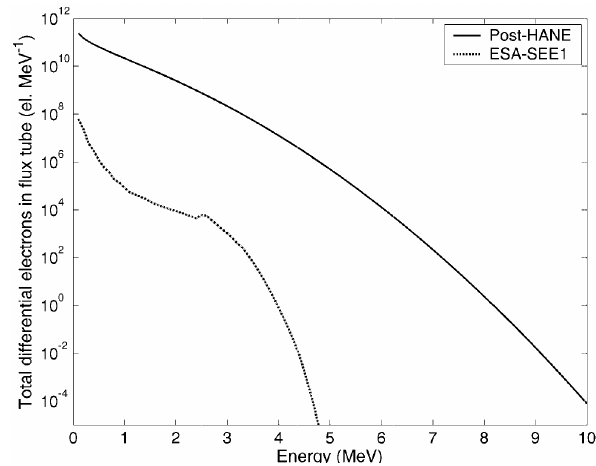
Fig. 3. The differential number of electrons in a tube at L =1.57 having 1 cm 2 area perpendicular to B at 100km altitude, N 100km (E , L) , after the injection of energetic electrons from a HANE (sold line), and that predicted for undisturbed conditions from the ESA-SEE1 trapped electron model (dash-dot